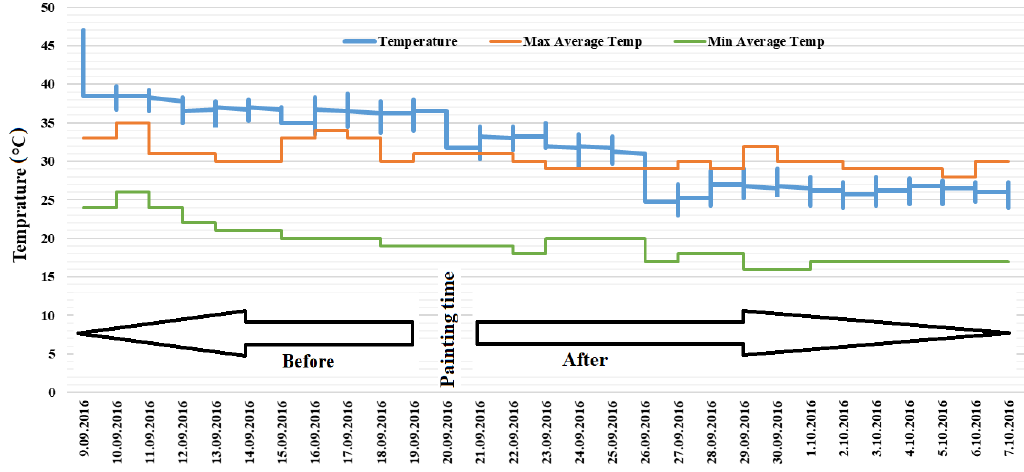
Figure 7. Measurement values of daily average and maximum/minimum temperatures for TR1.